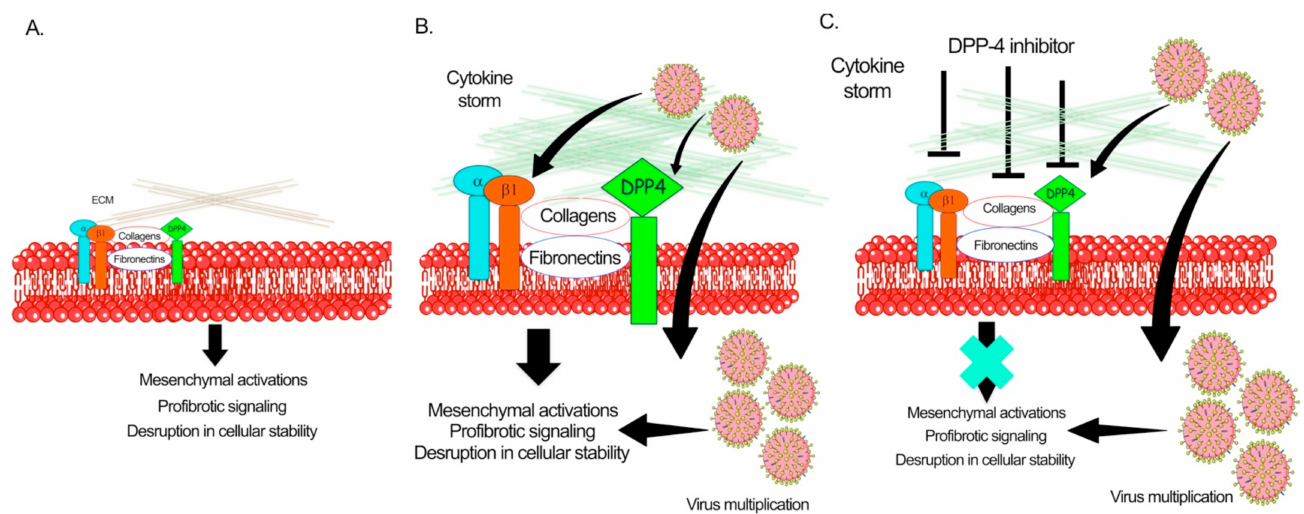
Figure 4. Pathological role of dipeptidyl transferase-4 in COVID-19 associated nephropathy in diabetes. ( A ) Healthy kidney cells. ( B ) SAR-CoV-2 infection and associated cytokine storm elevates DPP-4-Integrin- β 1 interactions, induce mesenchymal activations and profibrotic signaling in the kidneys cells subsequently lead to higher ECM deposition, collagens and fibronectin accumulation. ( C ) DPP-4 inhibition cancels the mesenchymal transition processes and, suppresses pro-fibrotic signaling, ECM deposition, fibronectin and collagen accumulation. Servier medical art illustrations were used to design the